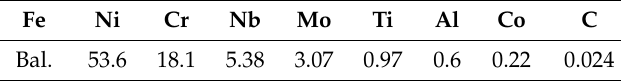
Table 2. Chemical composition (wt.%) of the IN718 powder